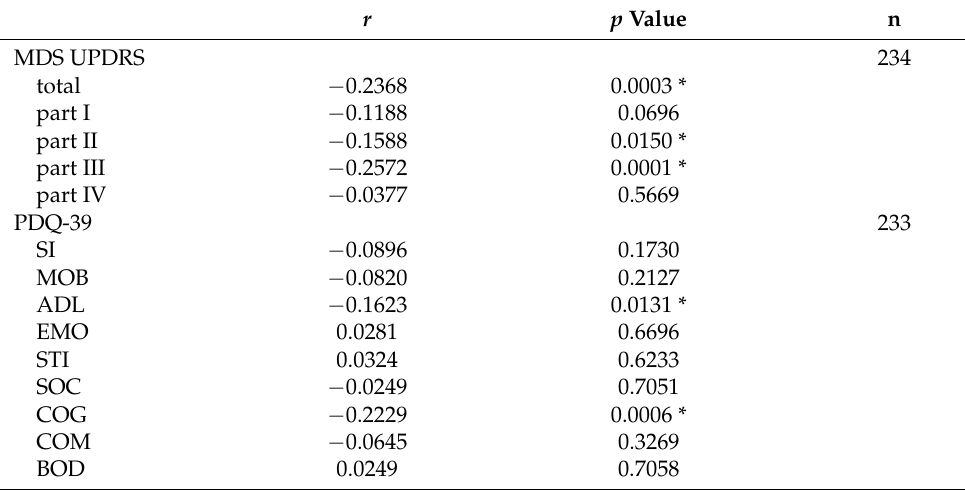
Table 3. Correlation between MDS UPDRS and PDQ-39 with